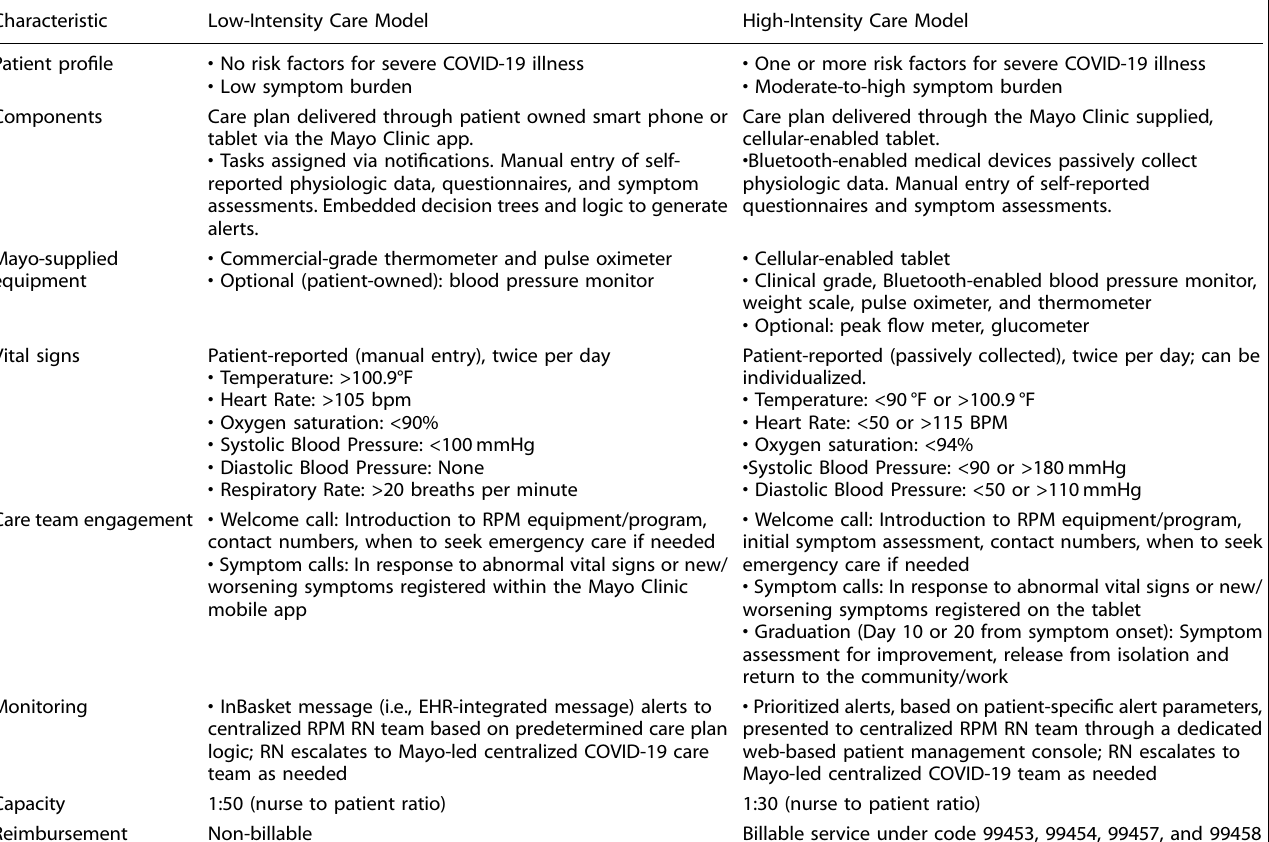
Table 1. COVID-19 RPM program care model differences. Characteristic Low-Intensity Care Model High-Intensity Care